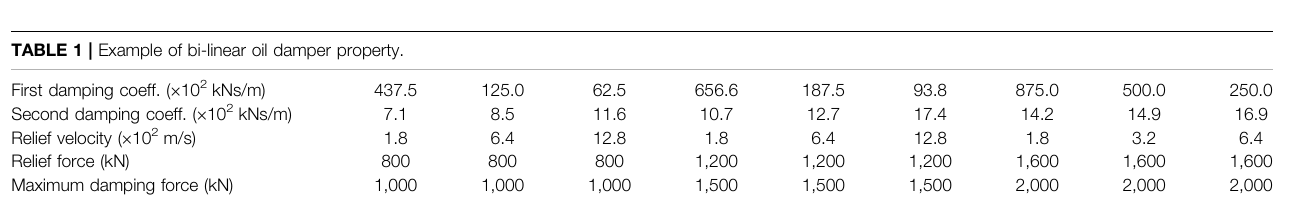
TABLE 1 | Example of bi-linear oil damper property. First damping coeff. ( × 10 2